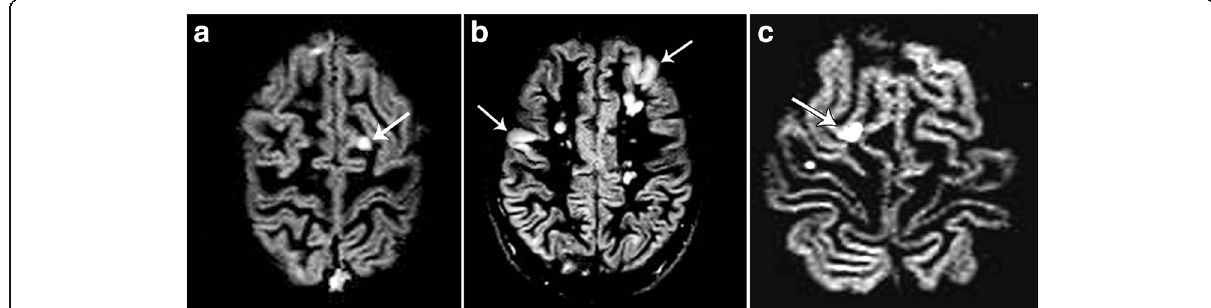
Fig. 2 Axial DIR images showing cortical lesion morphology: a Oval-shaped cortical lesion in the left frontal region. b Two curvilinear-shaped cortical lesions in the right frontoparietal and left frontal regions. c A wedge-shaped cortical lesion in the right frontal